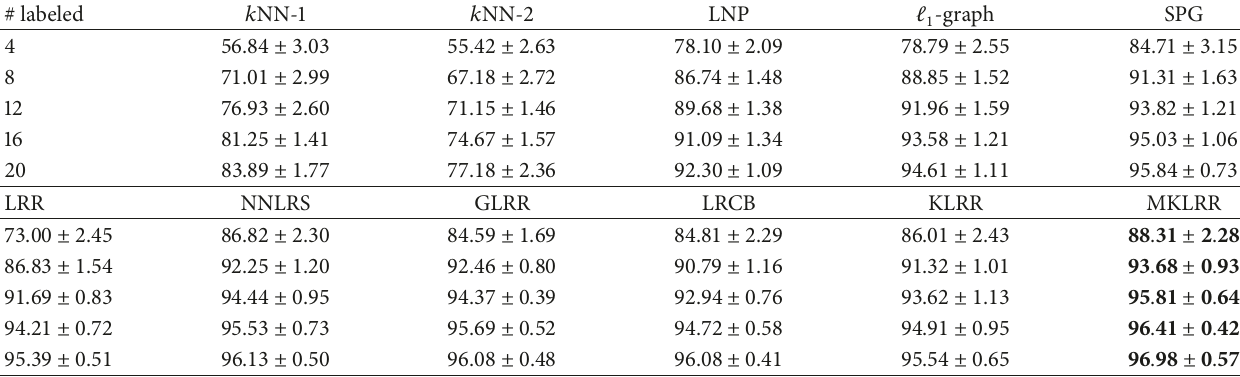
Table 4: Classification accuracies (%) of different algorithms with different number of labeled samples on the PIE data set. # labeled 𝑘 NN-1